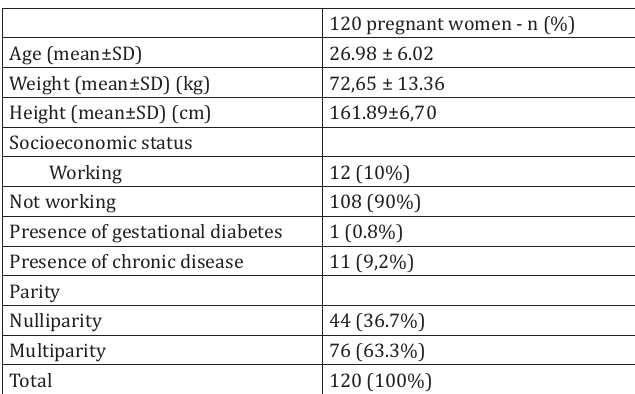
The demographic characteristics of the pregnant women who have musculoskeletal problems.